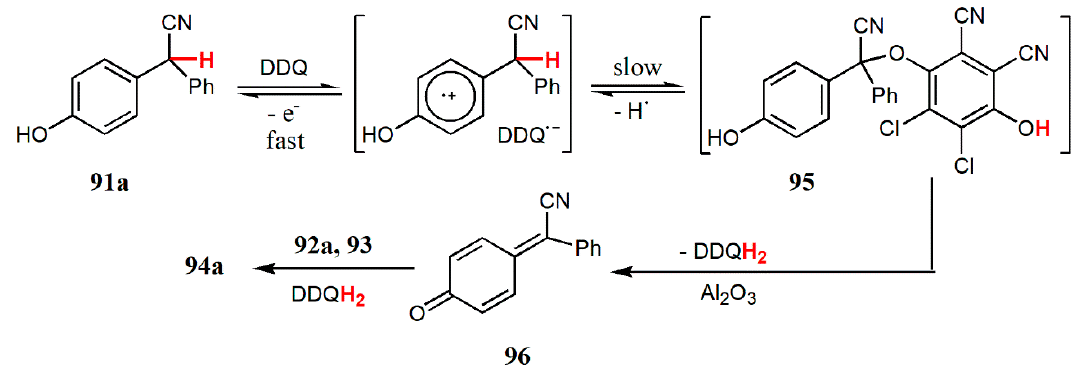
Figure 28. Synthesis of heteroarenes bearing triarylmethanes units with chiral all-carbon quaternary stereocenters.